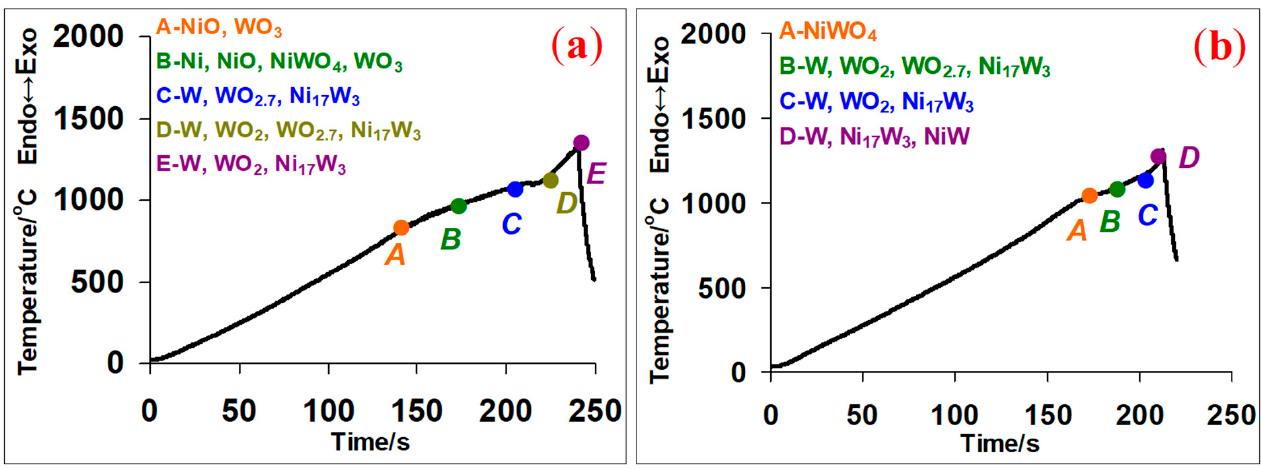
Figure 2. Heating curves of the NiO + WO 3 + 4 C (( a ) A—850 °C, B—1000 °C, C—1080 °C, D—1150 °C and E—1300 °C) and NiWO 4 + 4 C (( b ) A—1050 °C, B—1100 °C, C—1200 °C and D—1260 °C) mixtures, β = 300 °C min − 1 .